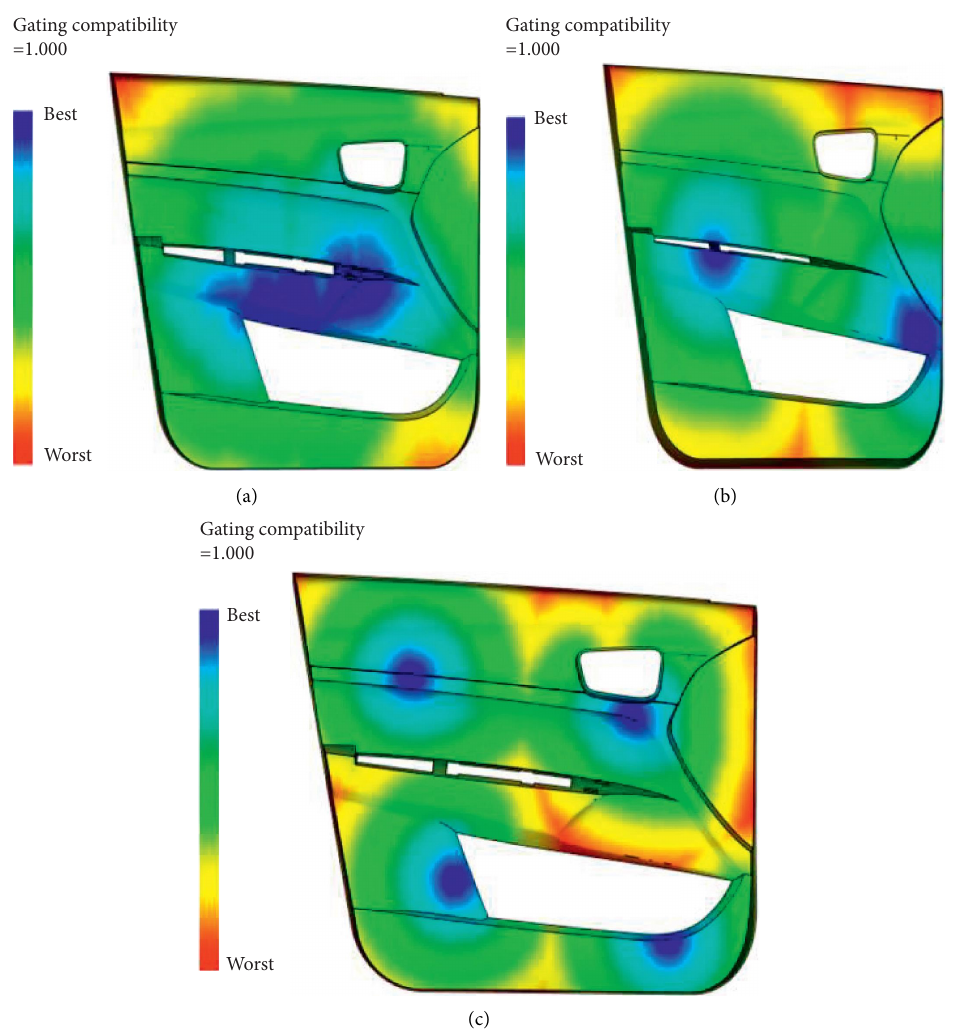
Figure 5: Matching cloud diagram of gates. (a) Matching cloud diagram of single gate. (b) Matching cloud diagram of two gates. (c) Matching cloud diagram of four